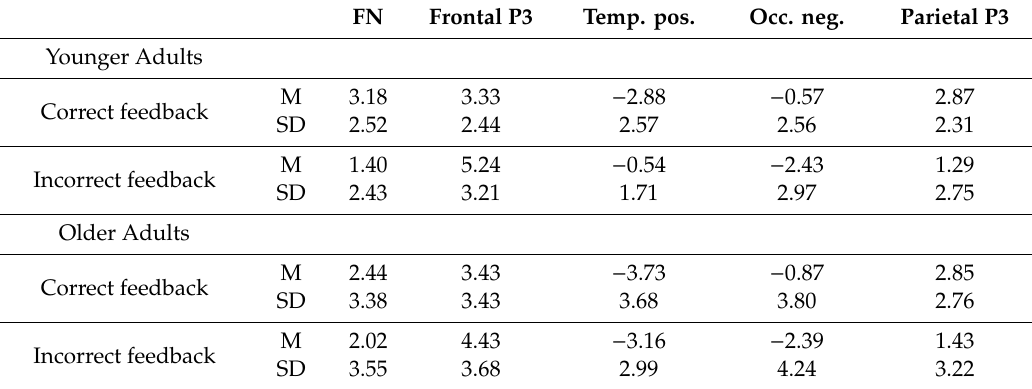
Table 3. Mean voltages in microvolts and standard deviation for younger and older adults for correct and incorrect feedback trials related to the FN, frontal P3, temporal positivity (temp. pos.), occipital negativity (occ. neg.) and parietal P3. FN Frontal P3 Temp. pos. Occ. neg. Parietal